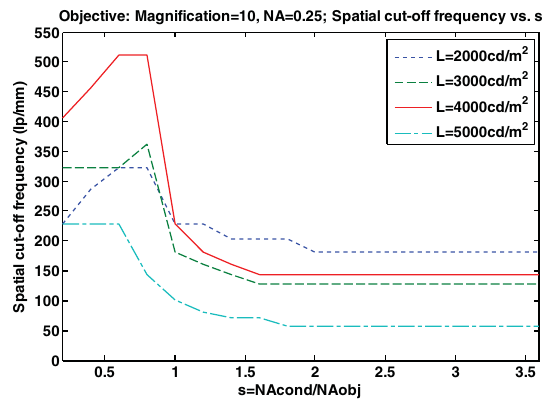
Fig. 7. The relation between spatial cut-off frequencies and s values under different light illumination conditions; the high- est spatial cut-off frequency is obtained when s =0.6–0.8 under L=2000–4000cd/m 2 . For L=5000cd/m 2 , the spatial cut-off fre- quency (resolution) is quite low due to too much flare (stray light), which lowers the pattern contrast.